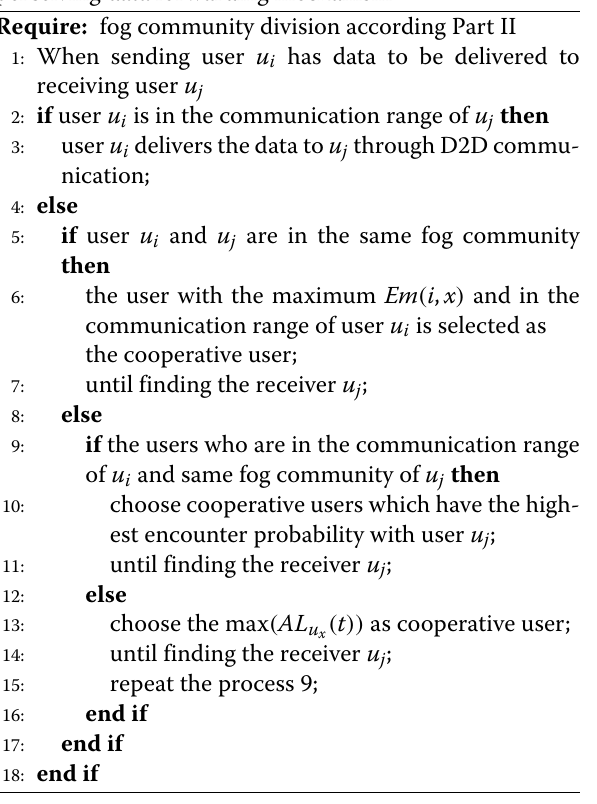
Algorithm 1 Physical and social attribute cooperative perceiving data forwarding mechanism